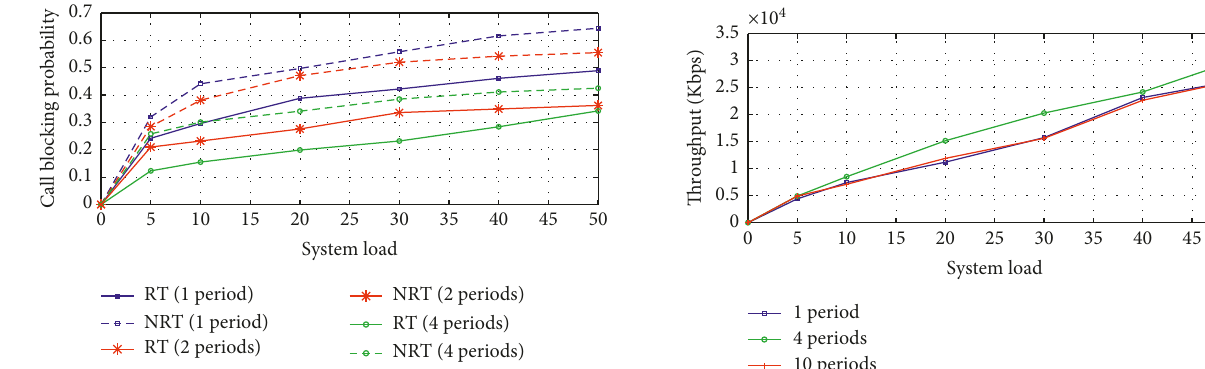
Figure 9: Throughput (shower rain event).